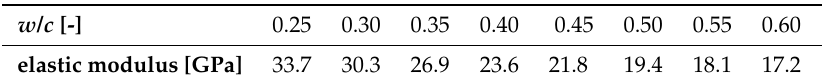
Table 1. Elastic moduli of mature cement pastes with different initial water-to-cement mass ratios at the age of 56 days after mixing [38].